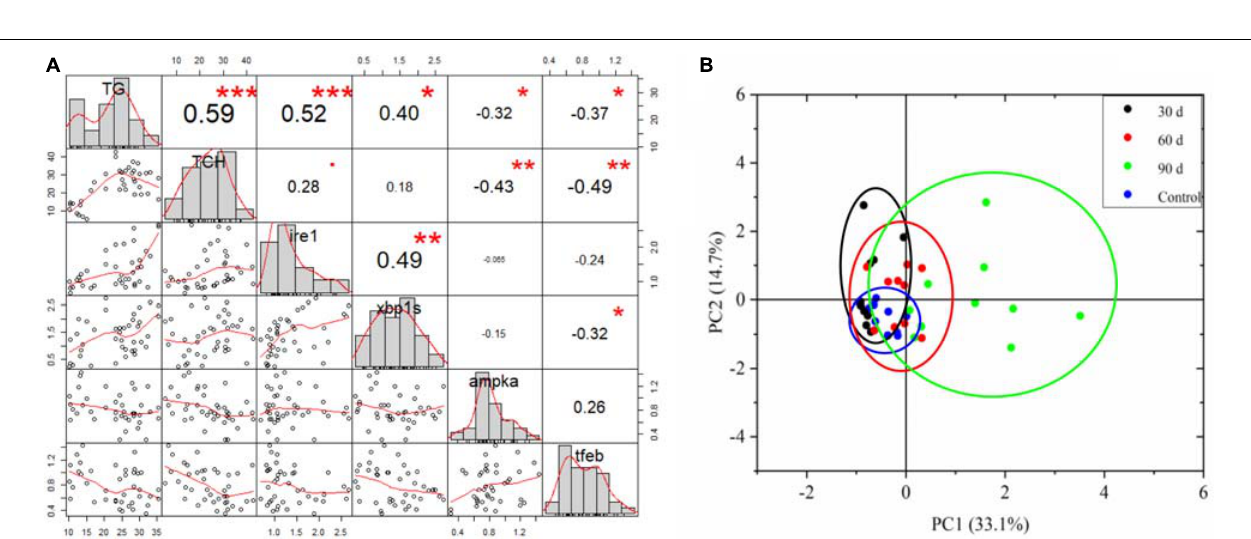
Frontiers in Marine Science |